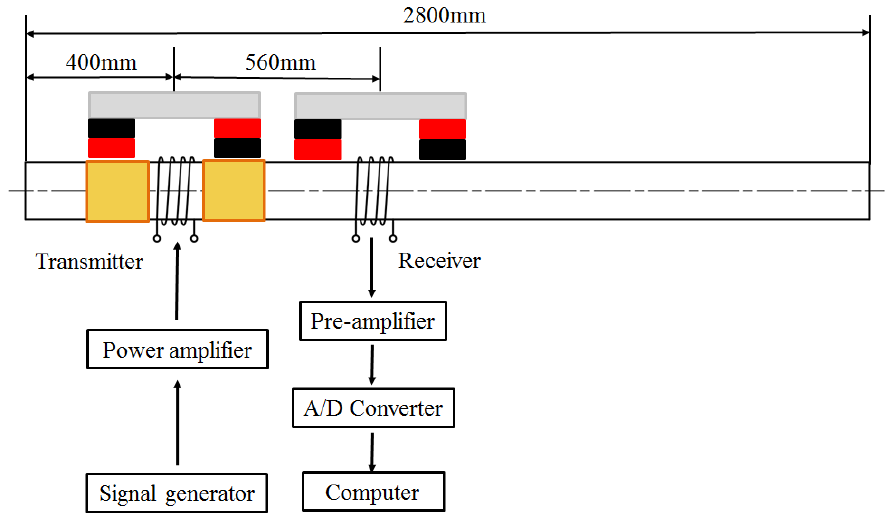
Figure 14. The experimental arrangement